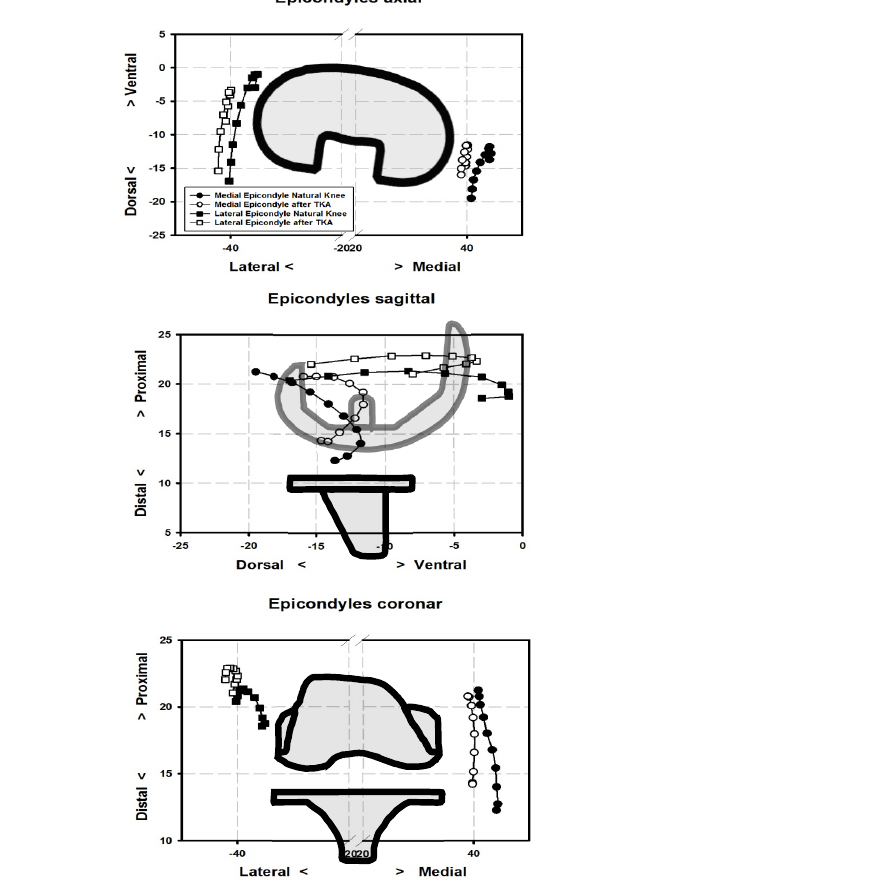
Figure 2. Positions of the medial epicondyles before (black dots) and after total knee arthroplasty (TKA) (white dots), and lateral epicondyles before (black squares) and after TKA (white squares) in millimetres between 0 and 90 ◦ of flexion are shown.